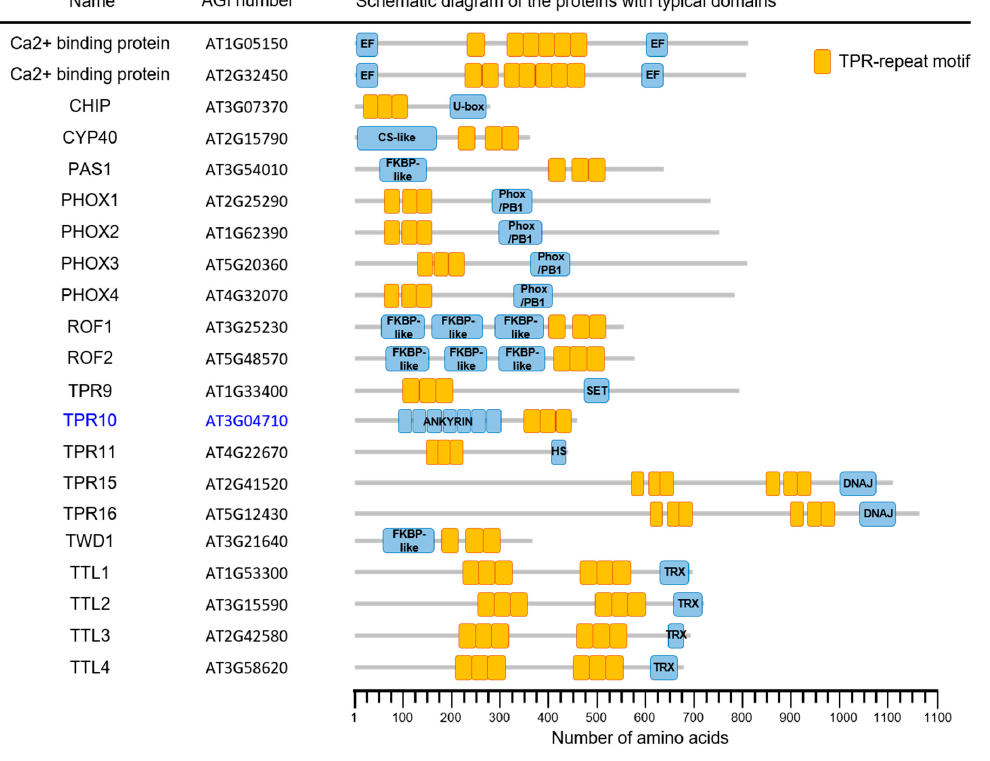
Figure 1. Schematic representation of the tetratricopeptide (TPR) repeat-containing proteins encoded by the Arabidopsis genome. These proteins contain several copies of the TPR domain (orange boxes), along with other functional domains (blue boxes). Among them, TPR10 domains selected in this study are indicated as blue characters. The scale at the bottom indicates the number of amino acid residues in these